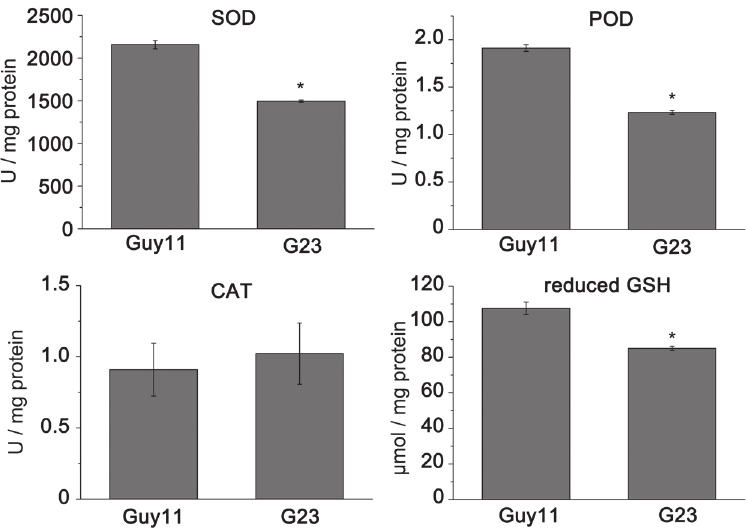
Fig 9. The activity of antioxidant enzymes and the content of GSH in tested M . oryzae strains. Activities of superoxide dismutase (SOD), catalase (CAT), and peroxidase (POD) and the content of reduced GSH in the tested strains were determined using assay kits purchased from Nanjing Jiancheng Bioengineering Institute (Nanjing, China). The experiments were performed in triplicate. Error bars represent SD. Asterisks in each data column indicate significant differences at p =